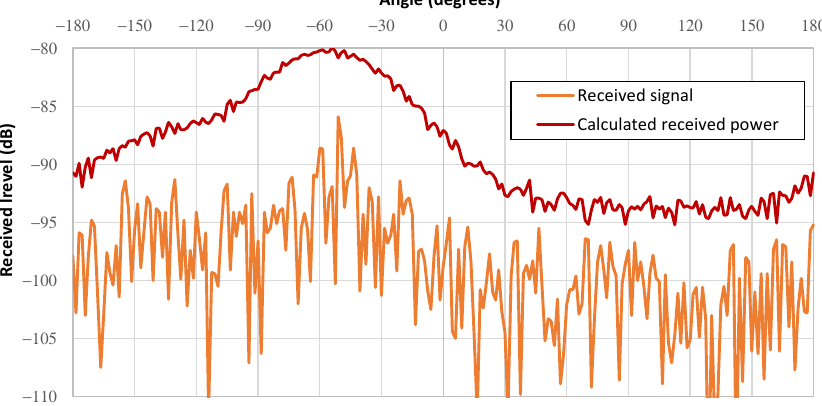
Figure 7. Calculated received power for the directional antenna—orientation 2. The received power was measured using the signal generator and the spectrum an-